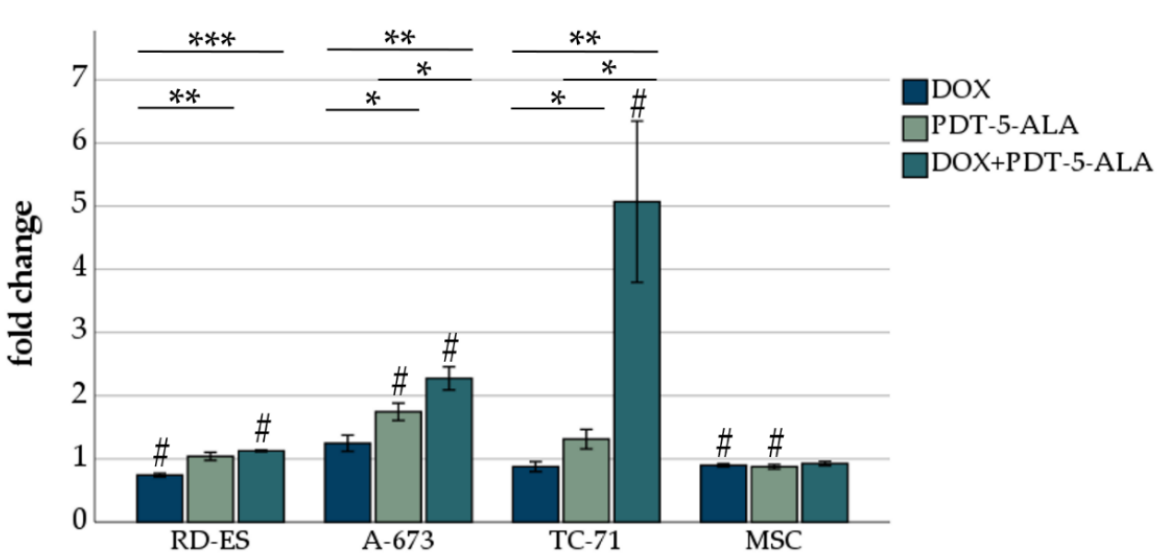
Figure 4. ROS assessment of ES cell lines after DOX treatment and PDT exposure. For DOX, 15 nM was chosen for all three ES cell lines (RD-ES, A-673, TC-71) as well as MSCs. For the photosensitizer 5-ALA, concentrations adapted to the sensitivity of the cell line were chosen (0.15 mM RD-ES, 0.25 mM TC-71, 0.35 mM A-673, and MSCs). Results are presented as mean fold difference of mock-treated control. Error bars indicate the standard deviations (* p < 0.05, ** p < 0.01, *** p < 0.001 relative to other treatment, # p < 0.05 compared to untreated control group). Abbreviations: 5-ALA — 5-ami-